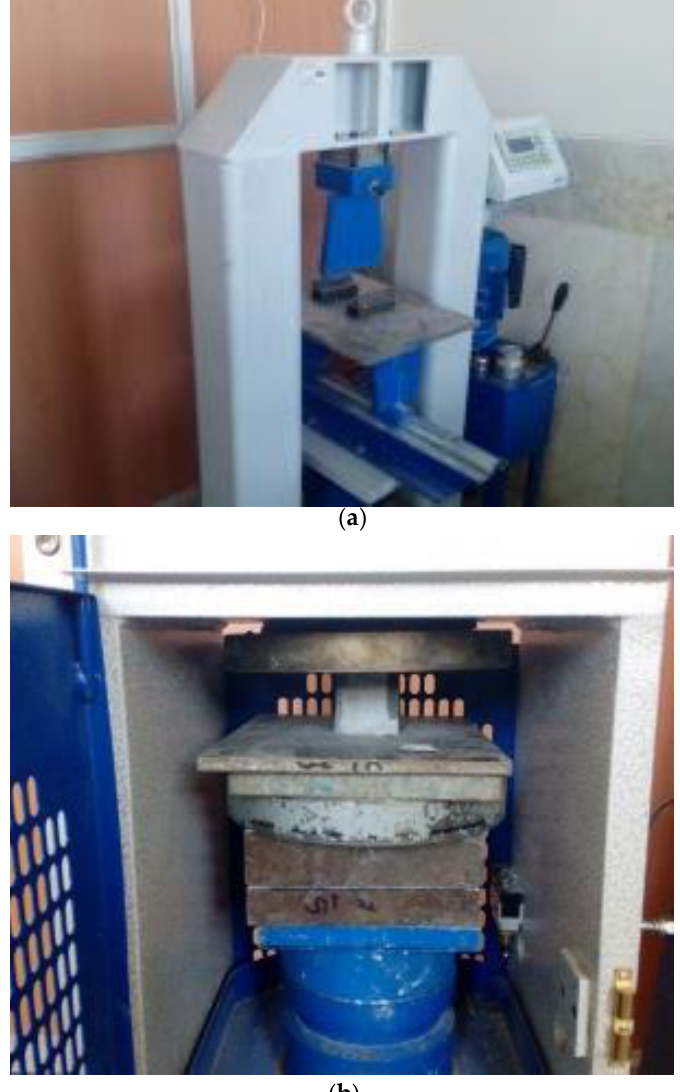
Figure 3. Testing machines used for ( a ) flexural strength and ( b ) compressive strength.